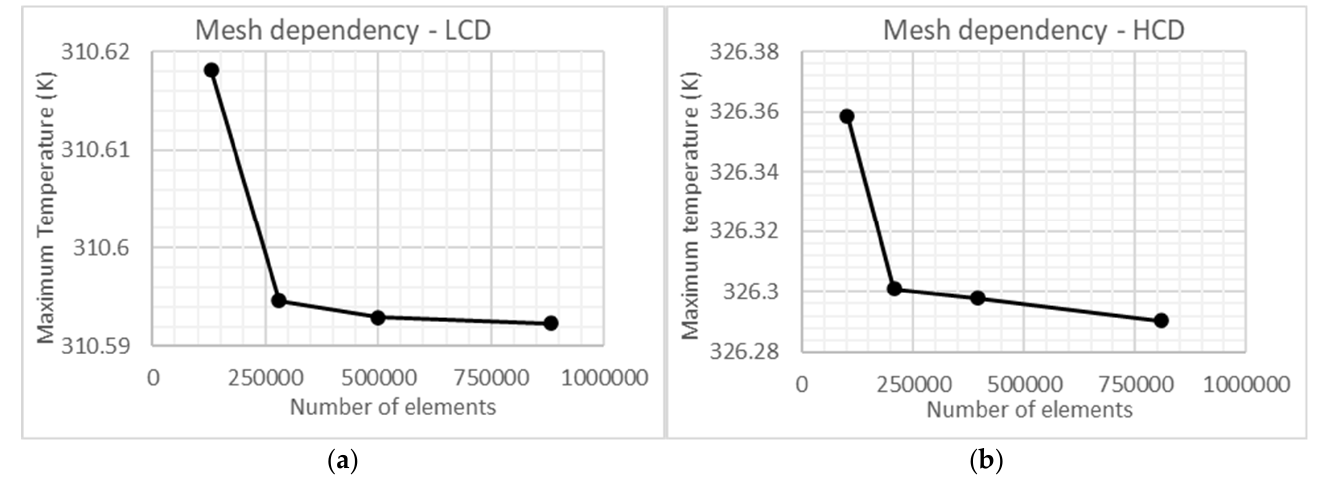
Figure 5. Mesh dependency study for the: ( a ) LCD; ( b ) HCD.